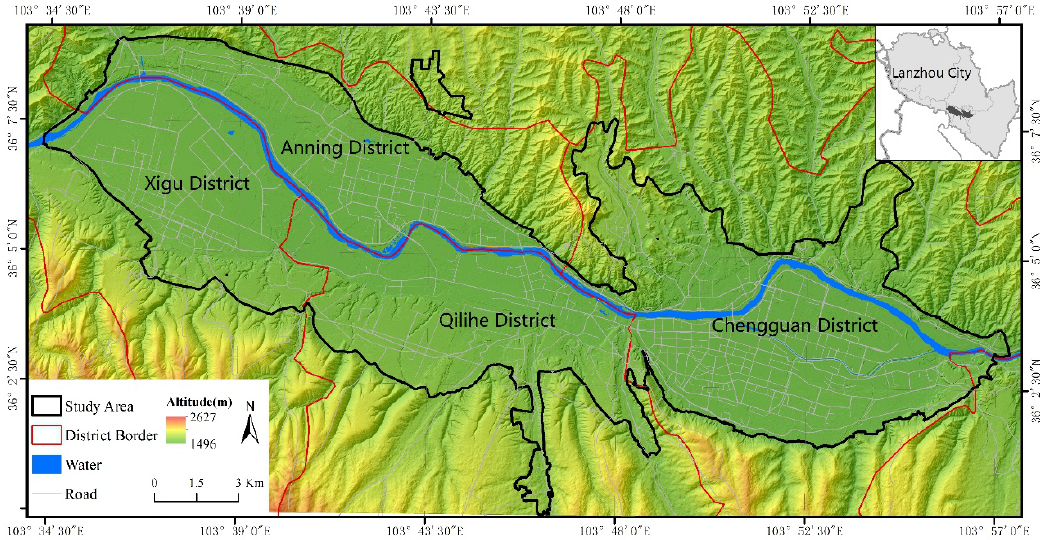
Figure 1. Overview of the study area. Table 1. Classification system.